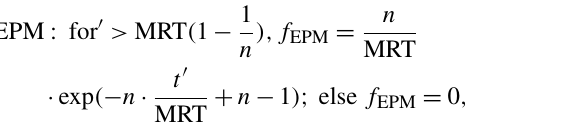
ployed, we only present results with regard to the